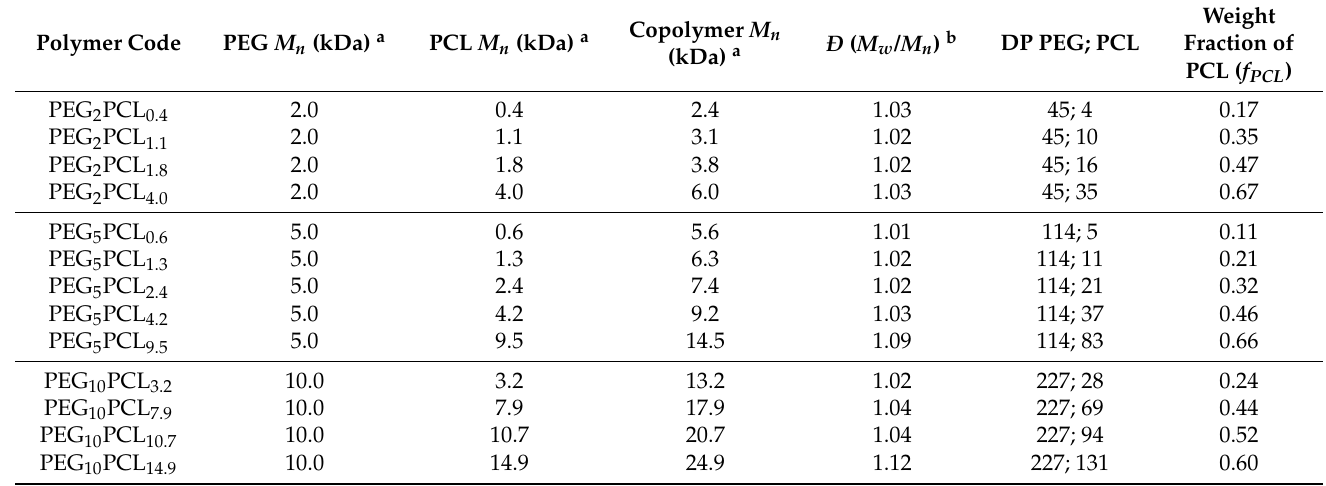
Table 1. PEG- b -PCL copolymer molecular weight characteristics, degree of polymerisation (DP), and weight fraction of hydrophobic block ( f PCL